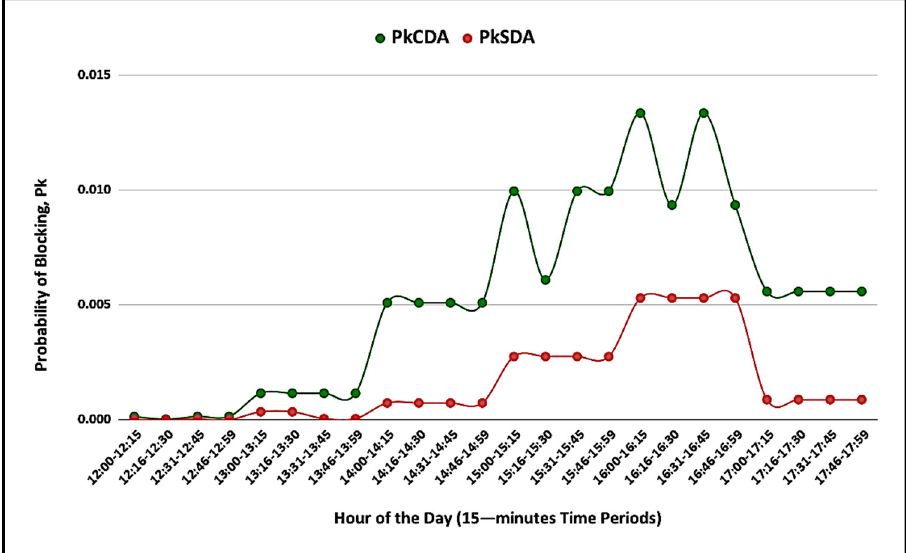
Figure 9. Probability of blocking of the two descent methods.